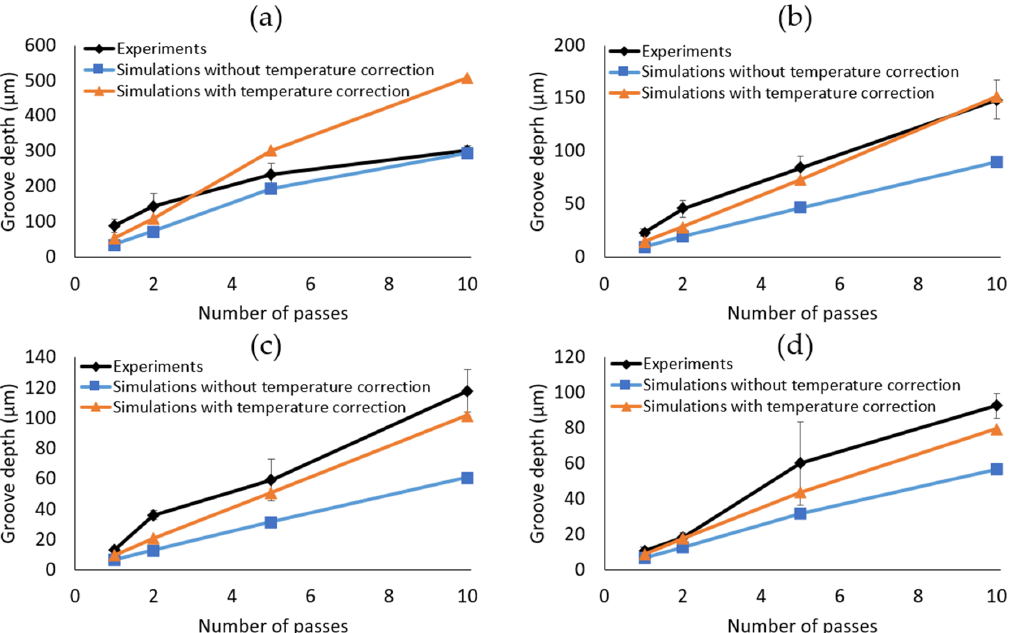
(cid:3404) 0.043 , 𝑐 (cid:3019) (cid:3404) = 0.043, c = 50) (cid:3295)(cid:3283) R th